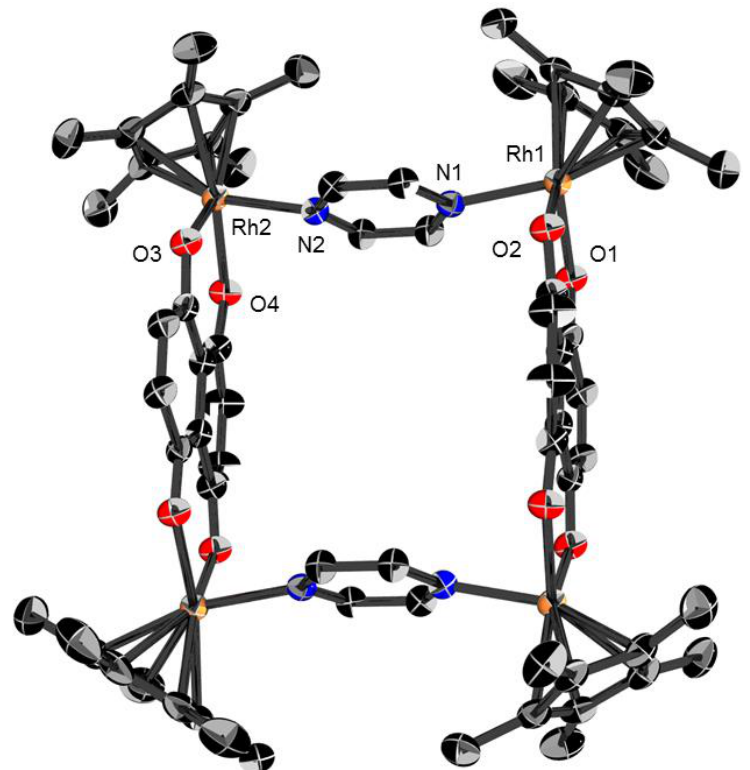
Figure 3. Molecular structure of metalla-rectangle 3 at 50% probability level ellipsoids with hydrogen atoms, dichloromethane molecules and triflate anions omitted for